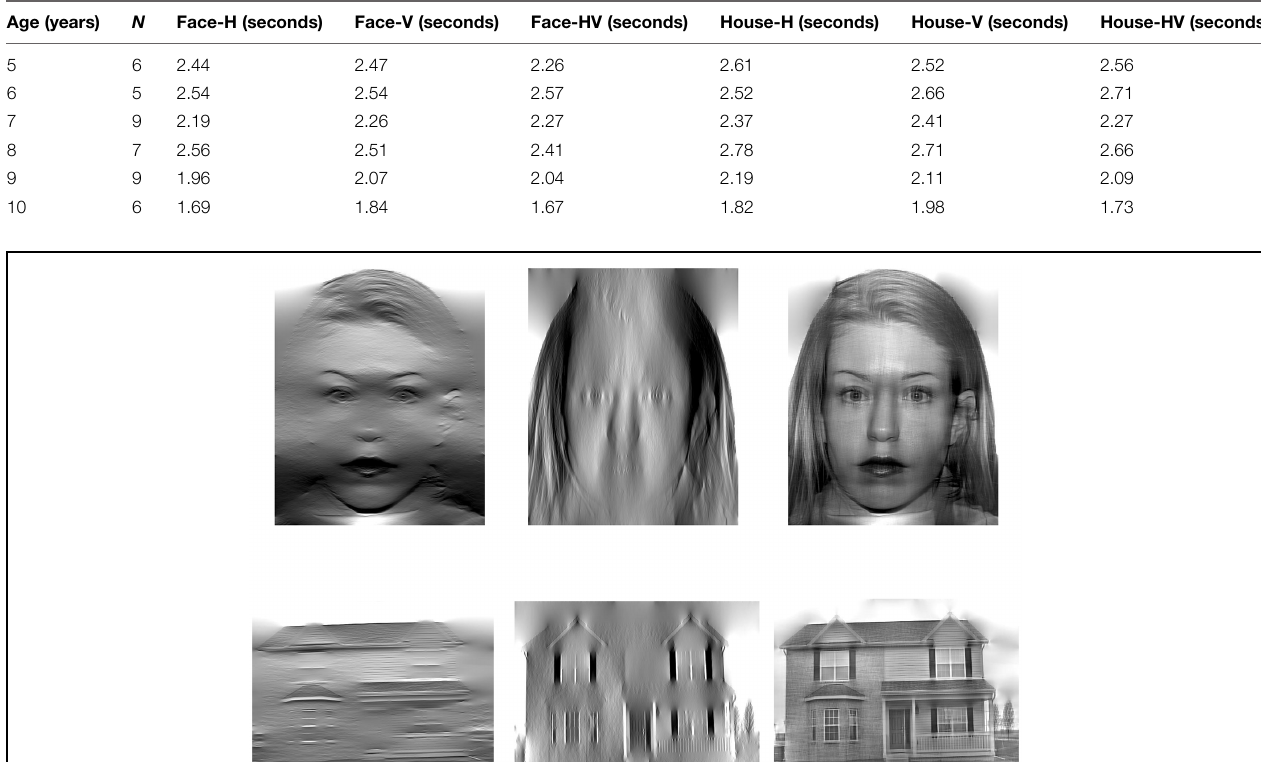
TABLE 1 | Average response time (calculated from ex-Gaussian parameter values) as a function of age and stimulus condition.